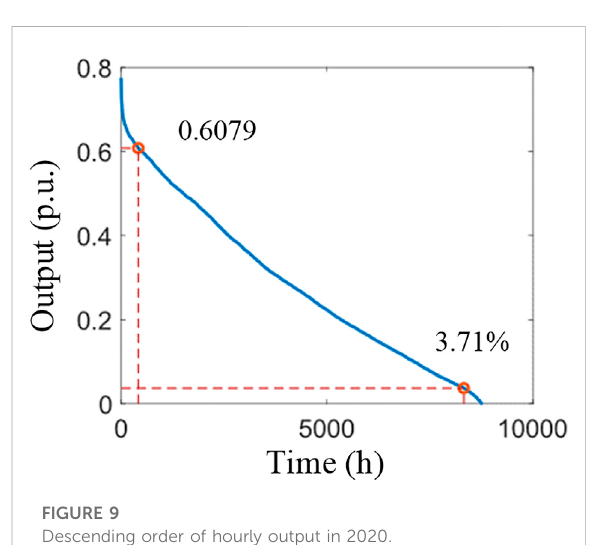
FIGURE 9 Descending order of hourly output in 2020.